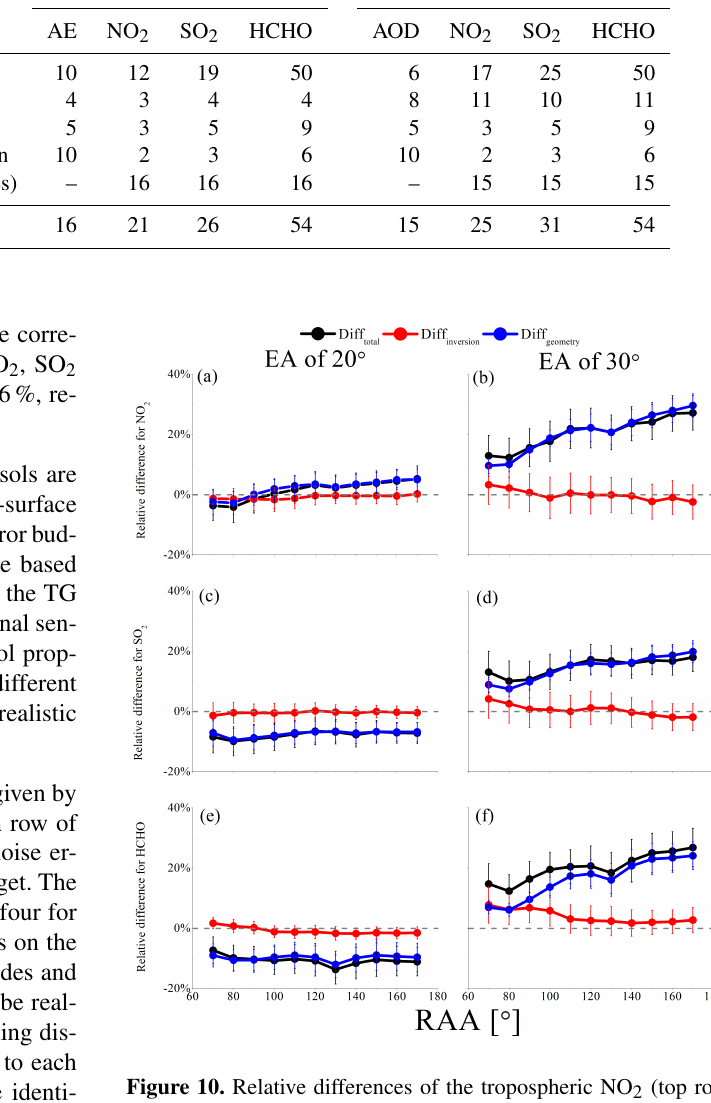
Figure 10. Relative differences of the tropospheric NO 2 (top row panels), SO 2 (middle row panels) and HCHO (bottom row panels) VCDs derived by the geometric approximation and from the profile inversion (Diff total , black dots) as a function of the relative azimuth angle for elevation angles of 20 ◦ (left panels) and 30 ◦ (right panels). Also shown are the differences caused by the errors of the profile retrieval (Diff inversion , red dots) and of the geometric approximation (Diff geometry , blue dots). Diff total , Diff inversion , and Diff geometry are calculated by Eqs. (3)–(5) in the